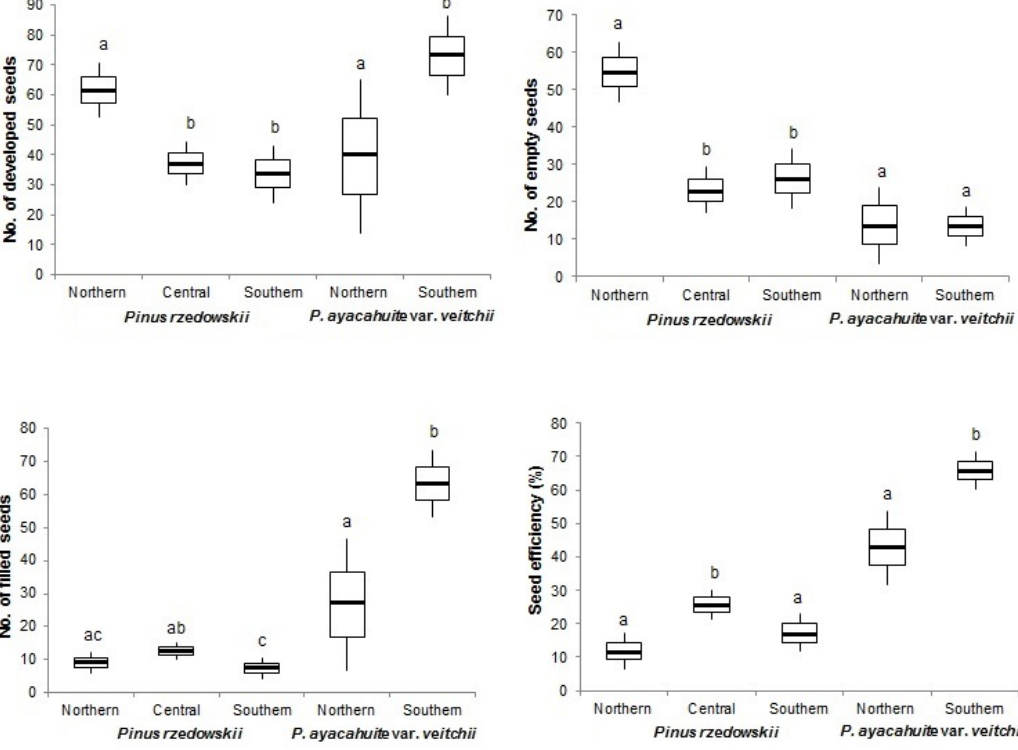
Figure 4. Tukey–Kramer test for the reproductive characteristics of cones and seeds for three zones of Rzedowski’s pine and two zones of veitchii pine. Vertical lines over each bar represent ± standard error. Letters indicate grouping based on α = 0.05.